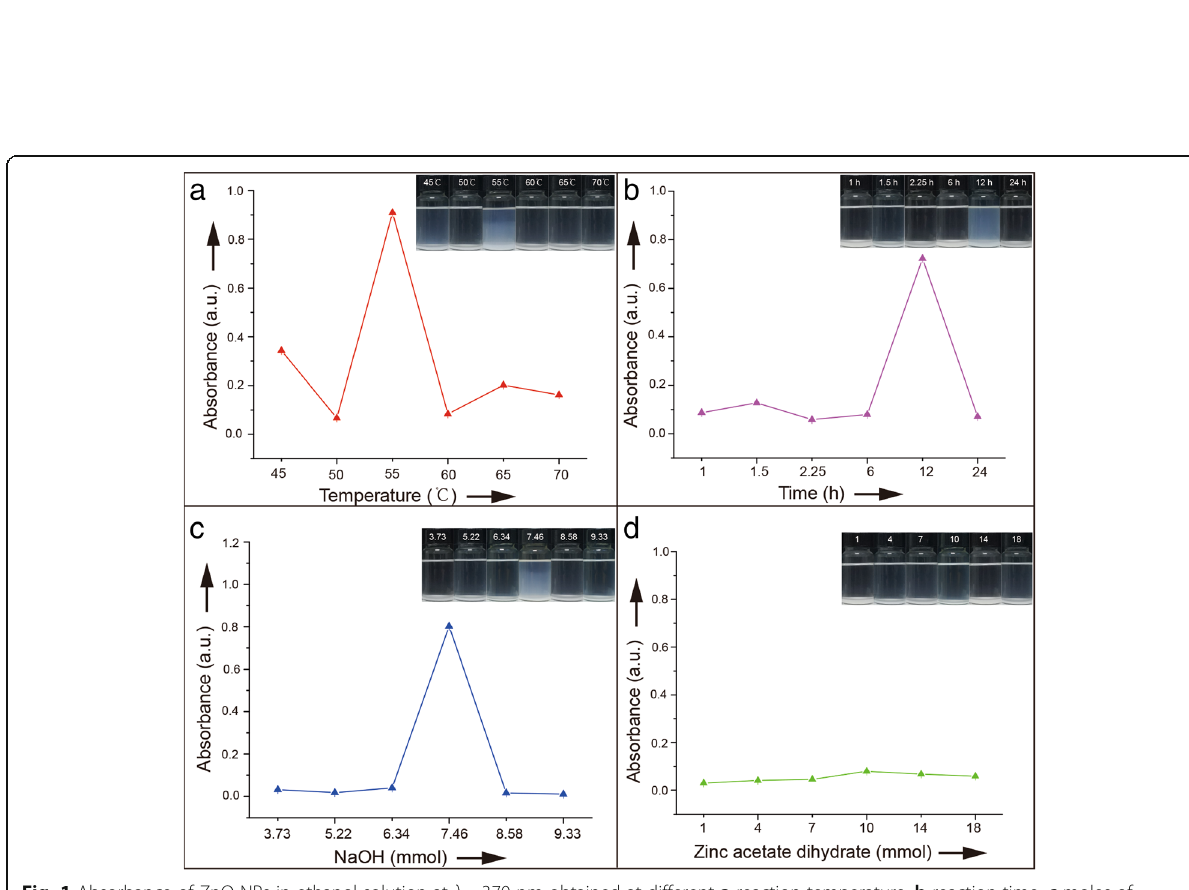
Fig. 1 Absorbance of ZnO NPs in ethanol solution at λ = 370 nm obtained at different a reaction temperature, b reaction time, c moles of sodium hydroxide, and d moles of zinc acetate dihydrate, after 3 weeks of aging at room temperature